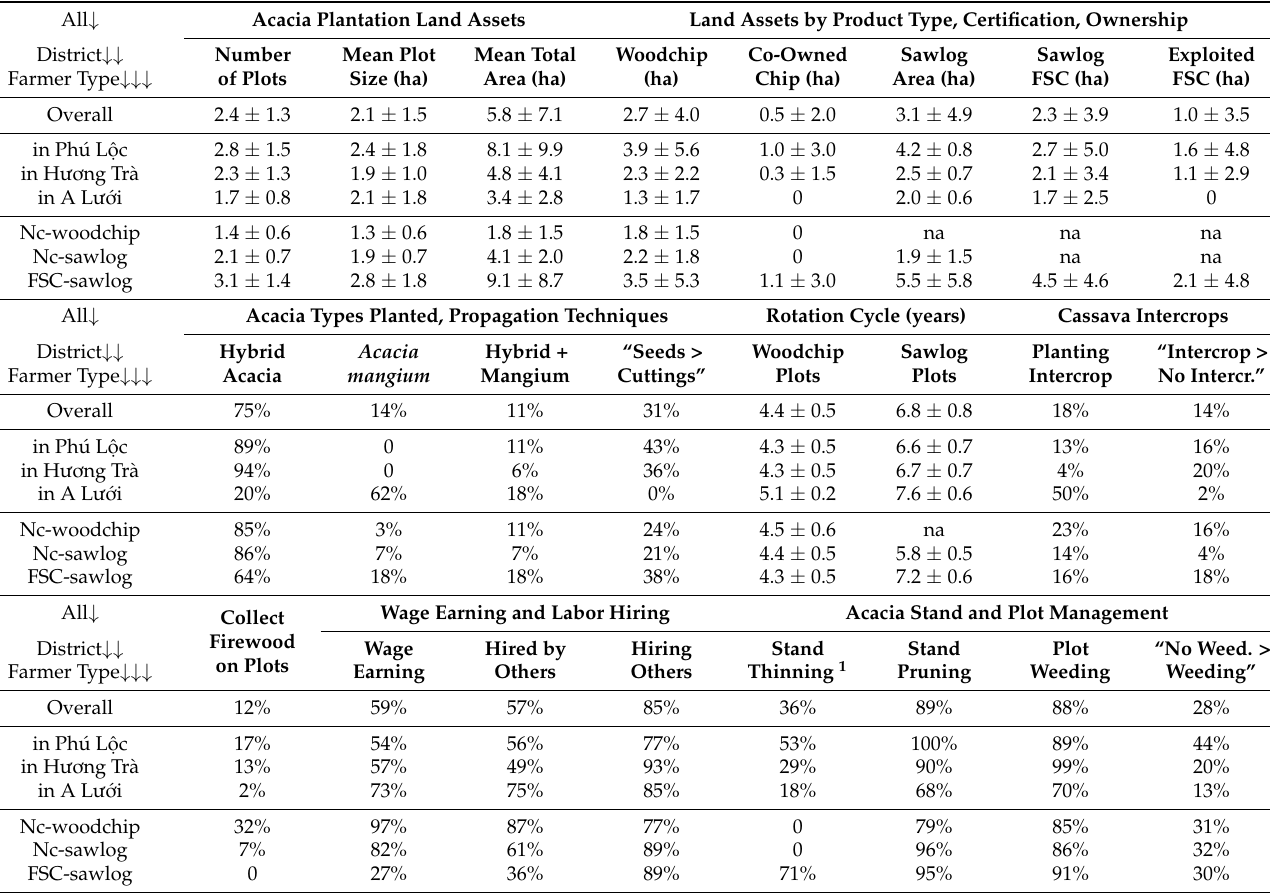
Table 5. Summary of data on plantation and other agricultural land assets, and on plantation management practices and techniques, showing differences among the three study districts and farmer